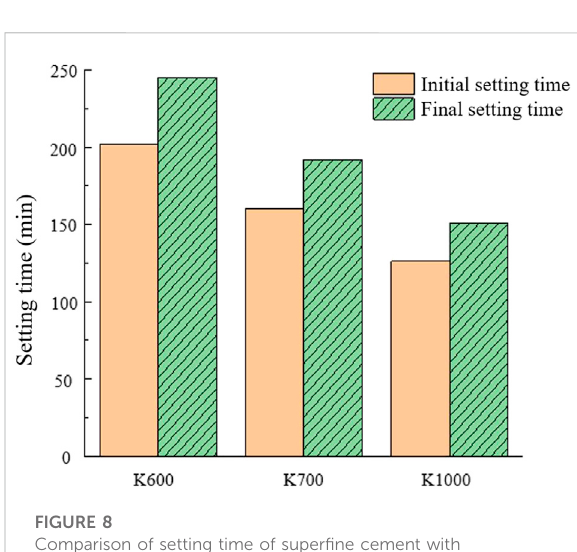
FIGURE 8 Comparison of setting time of super fi ne cement with different mesh